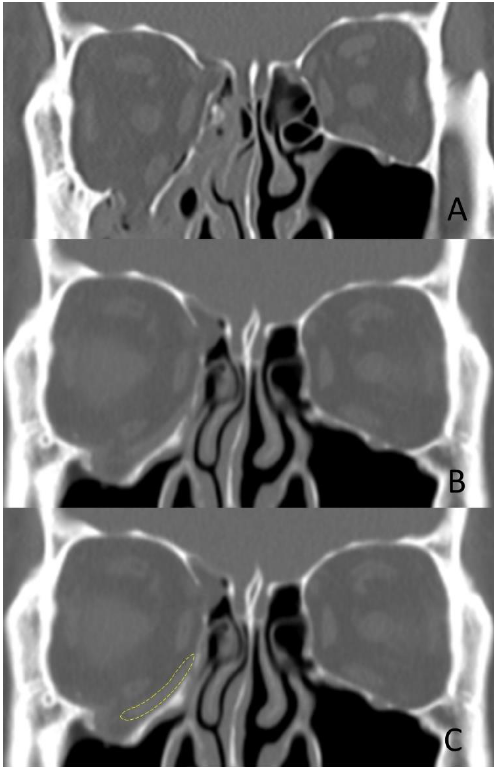
Figure 2. CT of a patient with a 3D-printed standardized implant (group ( A )) for a right orbital inferomedial fracture. ( A ) Preoperative CT. ( B ) At three months postoperative. ( C ) The implant outline is indicated by a yellow dotted line.